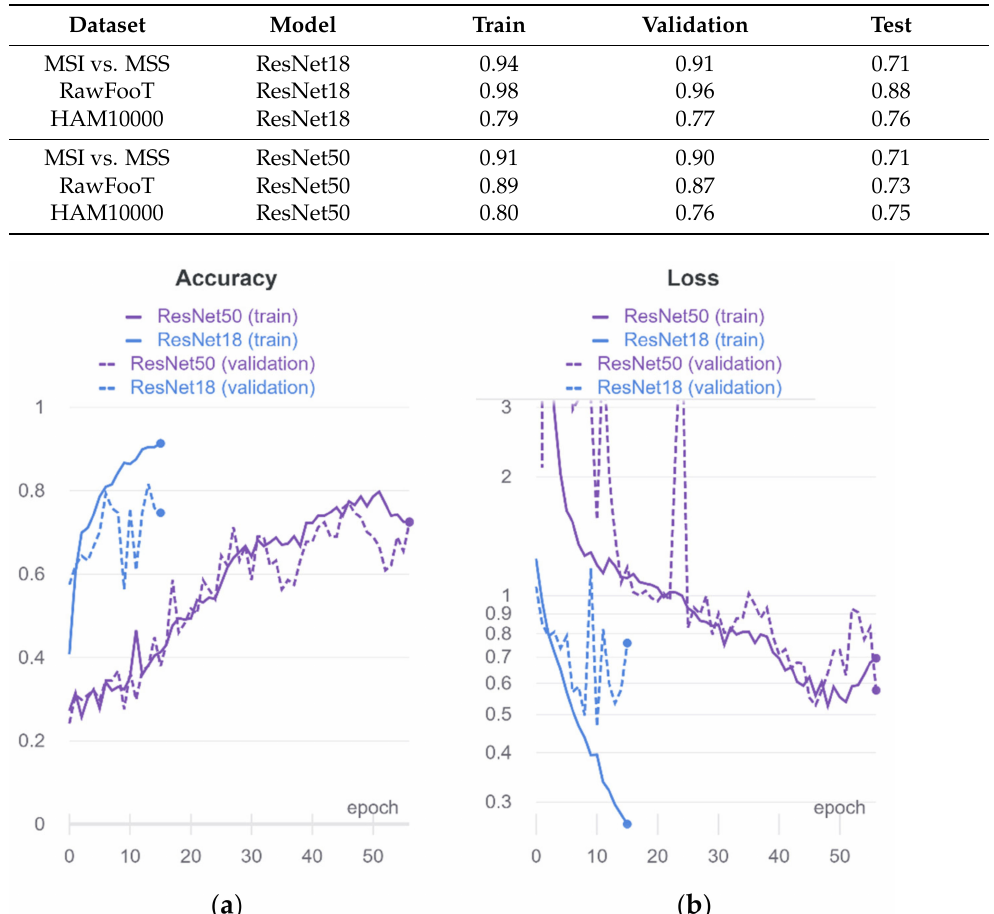
Figure 6. Training accuracy and loss for models trained on the thin-section data when the model starts with randomly initialized weights: ( a ) accuracy by epoch for the train and validation sets of models ResNet18 and ResNet50; ( b ) corresponding loss by